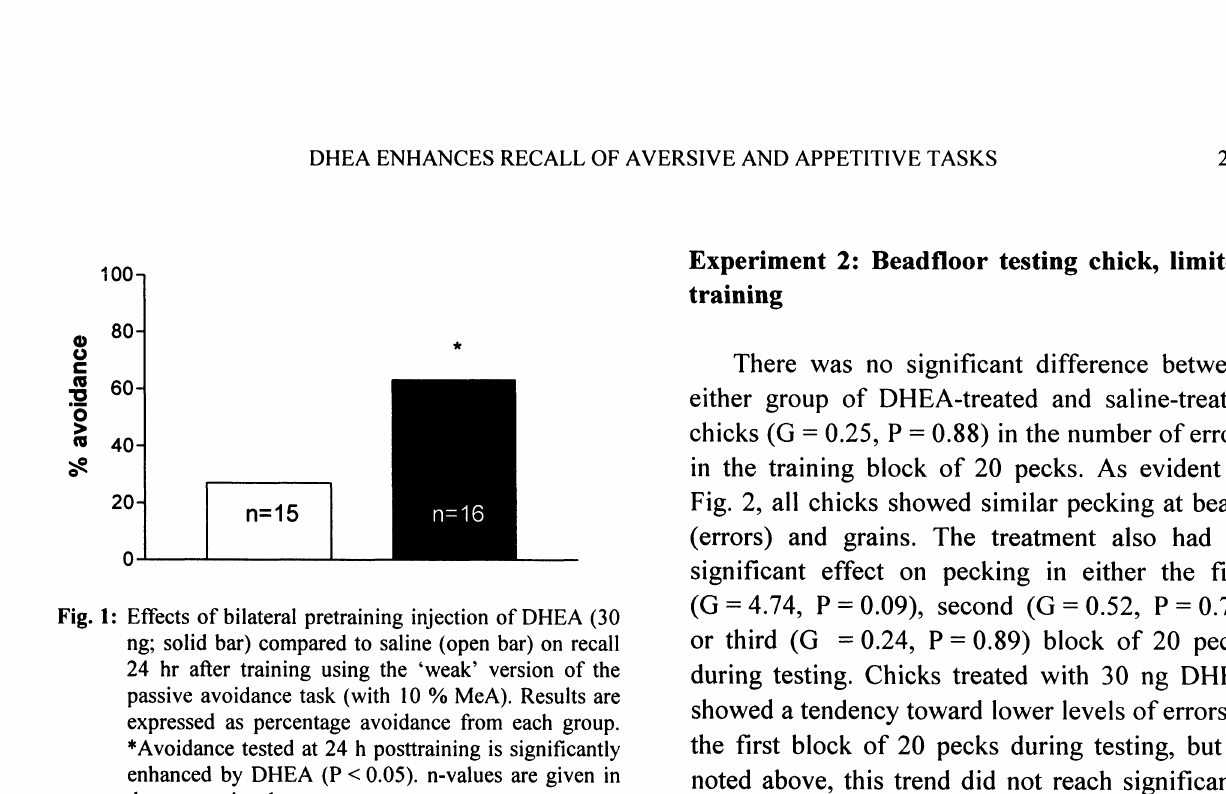
Fig. 1: Effects of bilateral pretraining injection of DHEA (30 ng; solid bar) compared to saline (open bar) on recall 24 hr after training using the ’weak’ version of the passive avoidance task (with 10 % MeA). Results are expressed as percentage avoidance from each group. *Avoidance tested at 24 h posttraining is significantly enhanced by DHEA (P < 0.05). n-values are given in the appropriate